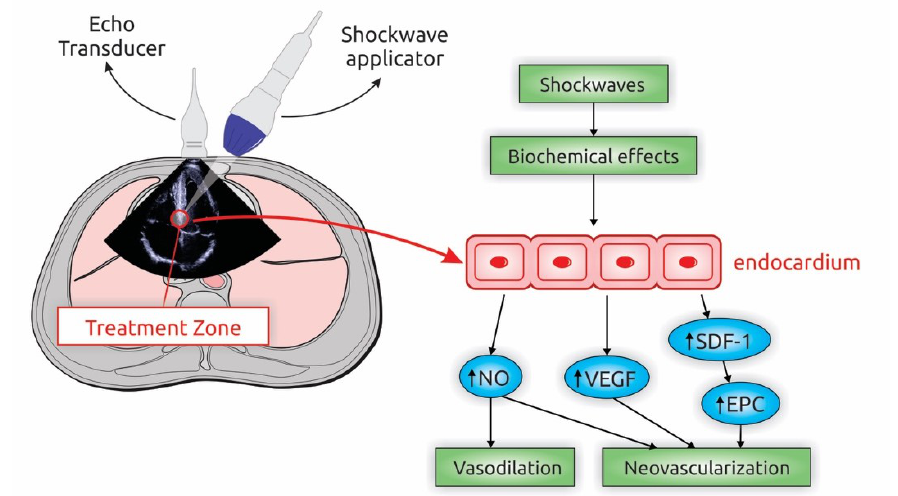
Figure 3. Schematic Presentation of the Extracorporeal Shockwave Myocardial Revascularization (ESMR) and putative mechanism of action. ESMR improves myocardial perfusion through the application of low-intensity shockwaves to ischemic areas. Shear stress on endocardial cell membranes, induced by shockwaves, is thought to lead to hyperpolarization, activation of Ras and formation of free radicals, with consequent enhancement in nitric oxide production (NO), up-regulation of chemoattractants, such as vascular endothelial growth factor (VEGF), stromal-derived factor-1 (SDF-1). These chemoattractants, in turn, can lead to progenitor cells recruitment to the ischemic tissue areas. EPC, endothelial progenitor cells.